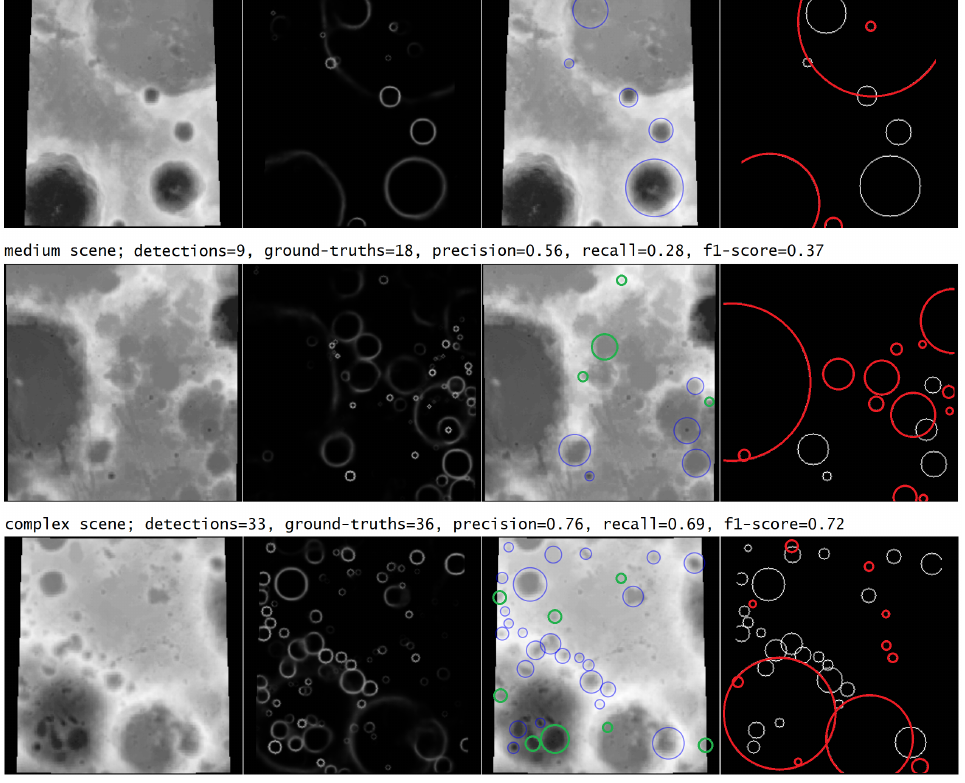
Figure 6. Examples of correct and incorrect predictions made for scenes of varying complexity. Going from the left: (i) input image, (ii) output of the model, (iii) craters detected by the template-matching step (false positives are rendered in green), and (iv) the ground truth (false negatives are in